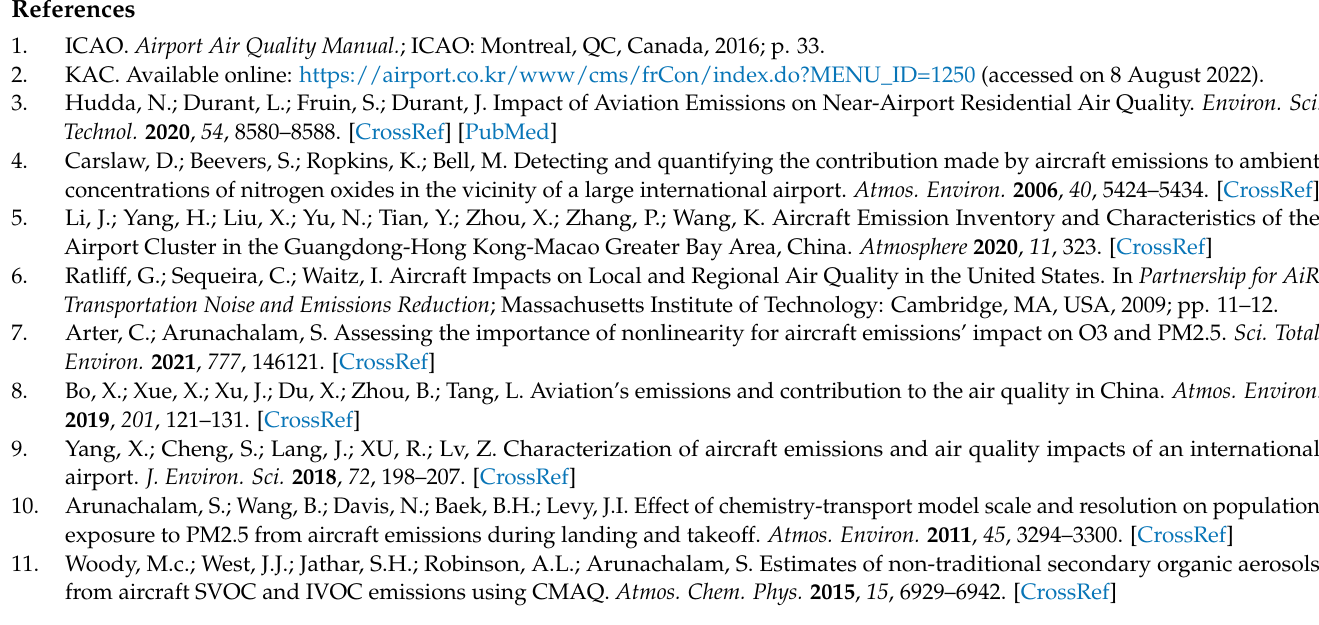
Table S3. Number of Total Flights in Each Airport for